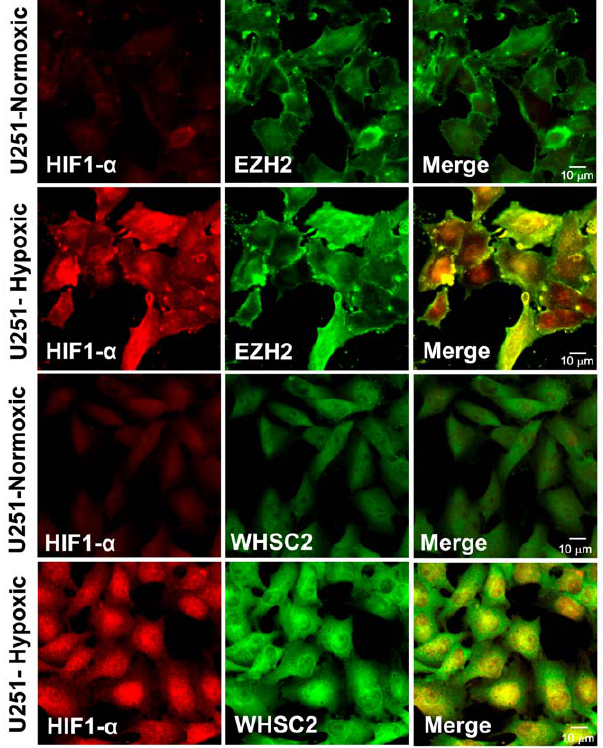
Figure 5. Hypoxia induces HIF-1 a expression along with EZH2 and Whsc2 in hypoxic U251 cells as detected by confocal microscopy. U251 cells were grown on a coverslips for 7 days either under normoxic or hypoxic conditions, the cells were fixed, permea- bilized and stained with the primary antibodies (HIF-1 a , EZH and Whsc2). The cells were then visualized at 40 6 magnification. The Top Panels compare the normoxic and hypoxic pairings of HIF-1 a and EZH2, while the Bottom Panels compare the HIF-1 a and Whsc2 pairings.